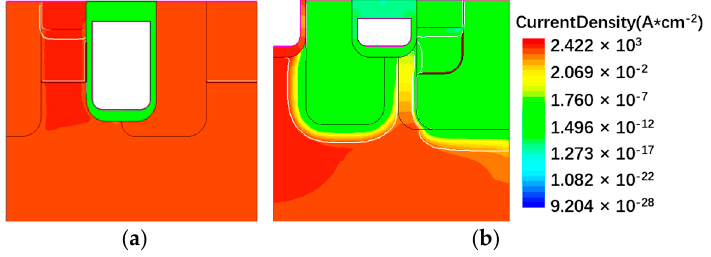
Figure 7. The current distribution of ( a ) C-MOS and ( b ) proposed structure.